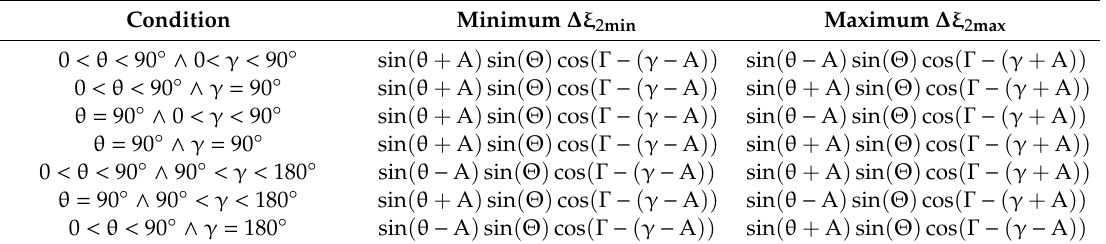
Table 1. The conditions by which the lower and upper boundaries of oscillations of the second term of Equation (16) are